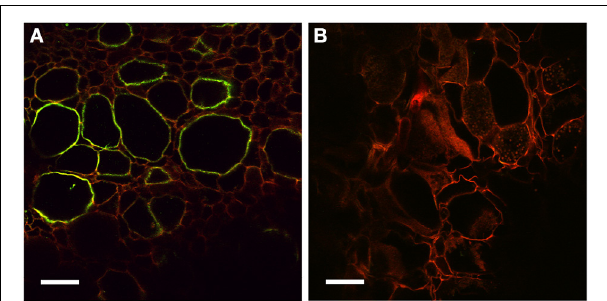
FIGURE 6 | Immunolocalization of PIN1-like proteins. (A) Longitudinal section of a mature nodule incubated with Anti-PIN1 antibodies and FITC labeled secondary antibodies: a strong signal is detected in the plasma membrane of hypertrophied cortical cells infected by Frankia . (B) Control section incubated with the secondary antibody alone where no signal is detectable. Scale bars: 50 µ m.